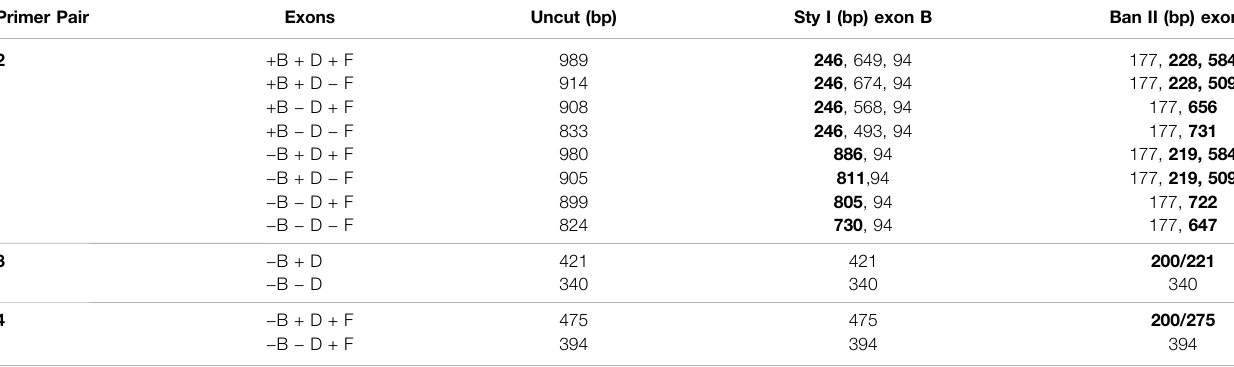
TABLE 2 | Nested PCR products and digestion fragments. Primer